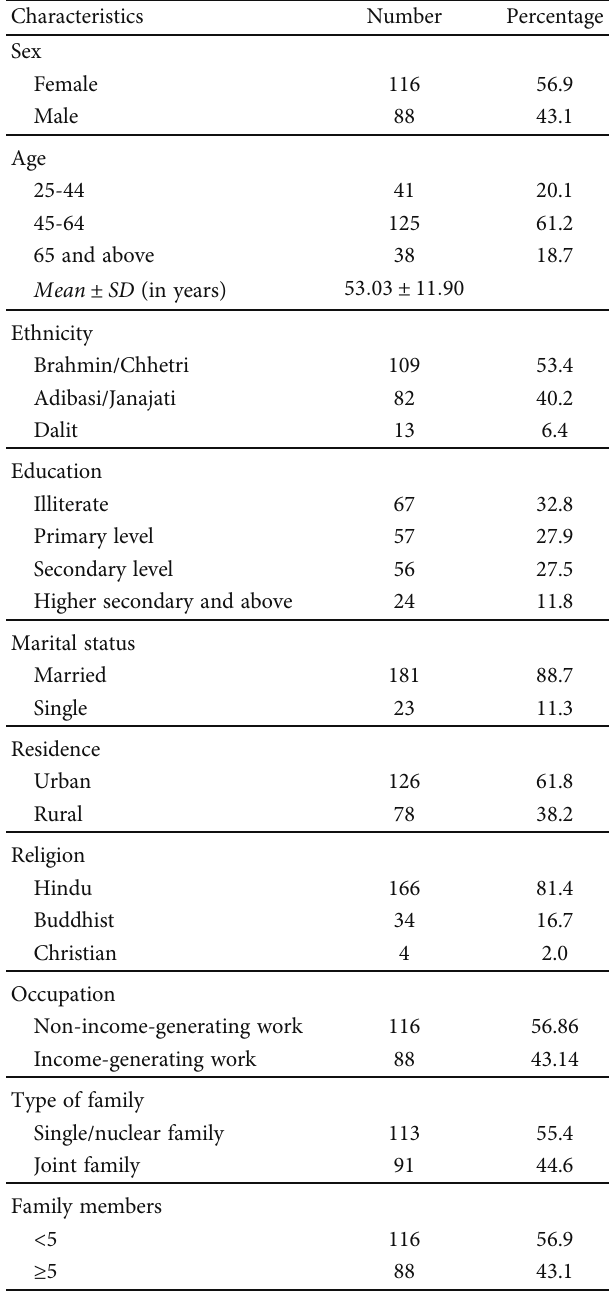
Table 1: Distribution of participants by their sociodemographic characteristics ( n = 204